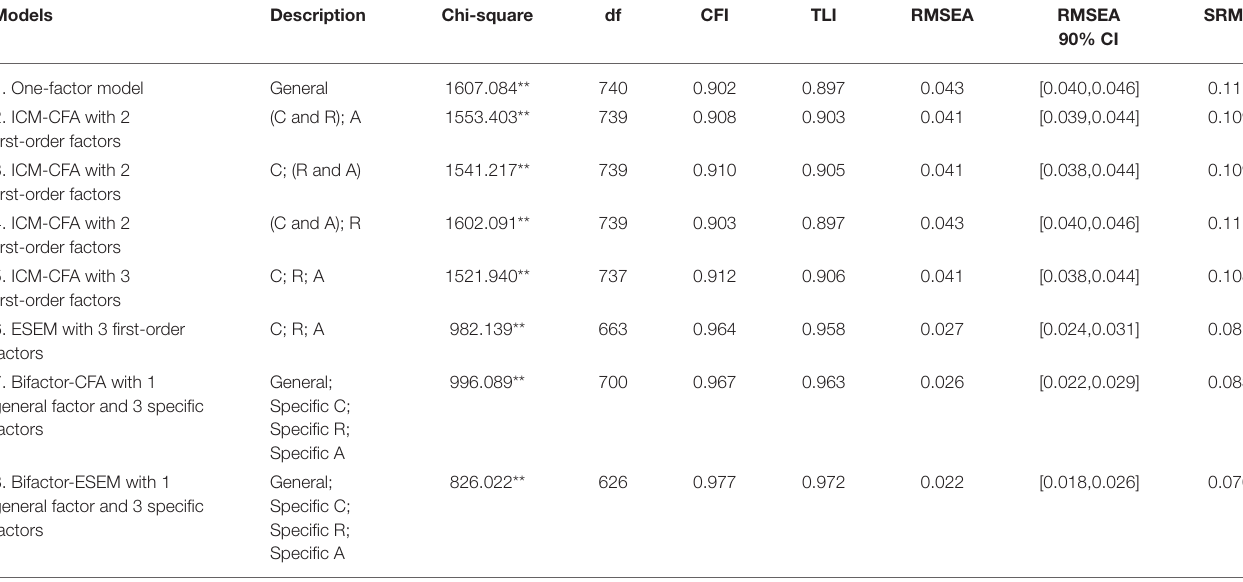
TABLE 2 | Goodness-of-fit indices for alternative models of early numeracy.